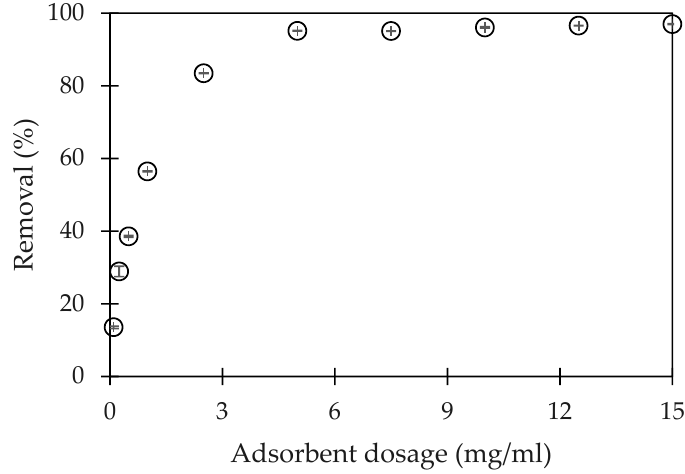
Figure 6. E ff ect of adsorbent dosage on CFX-removal by using PMA. (Ci (CFX) = 10 mg / L, contact time 90 min, pH 6, 1-mM NaCl). Error bars show standard deviation of three